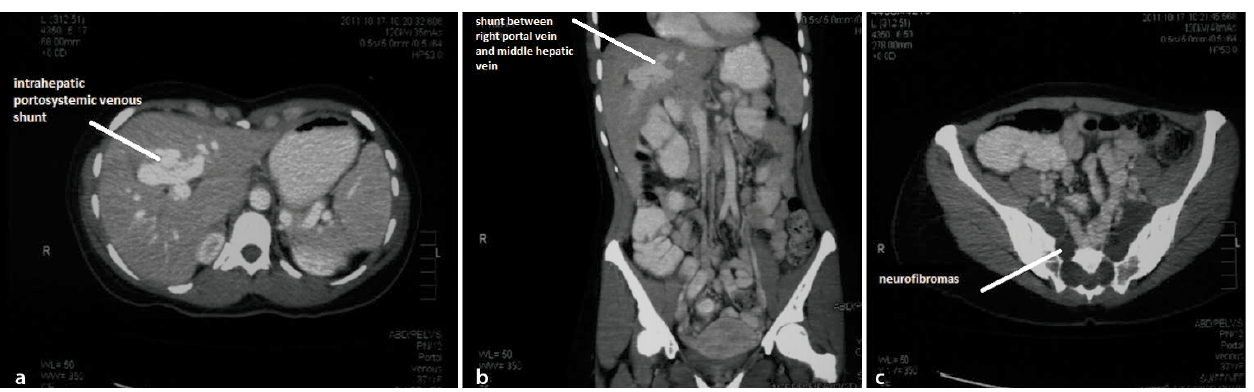
Fig. 1. (a) Axial post contrast CT image demonstrating intrahepatic portosystemic venous shunt between the right portal vein and middle hepatic vein. (b) Coronal post contrast CT image demonstrating communication between the right portal vein and the middle hepatic vein. (c) Axial CT image showing several non-enhancing hypodense lesions in the pelvis with enlarged, scalloped anterior sacral foramina consistent with